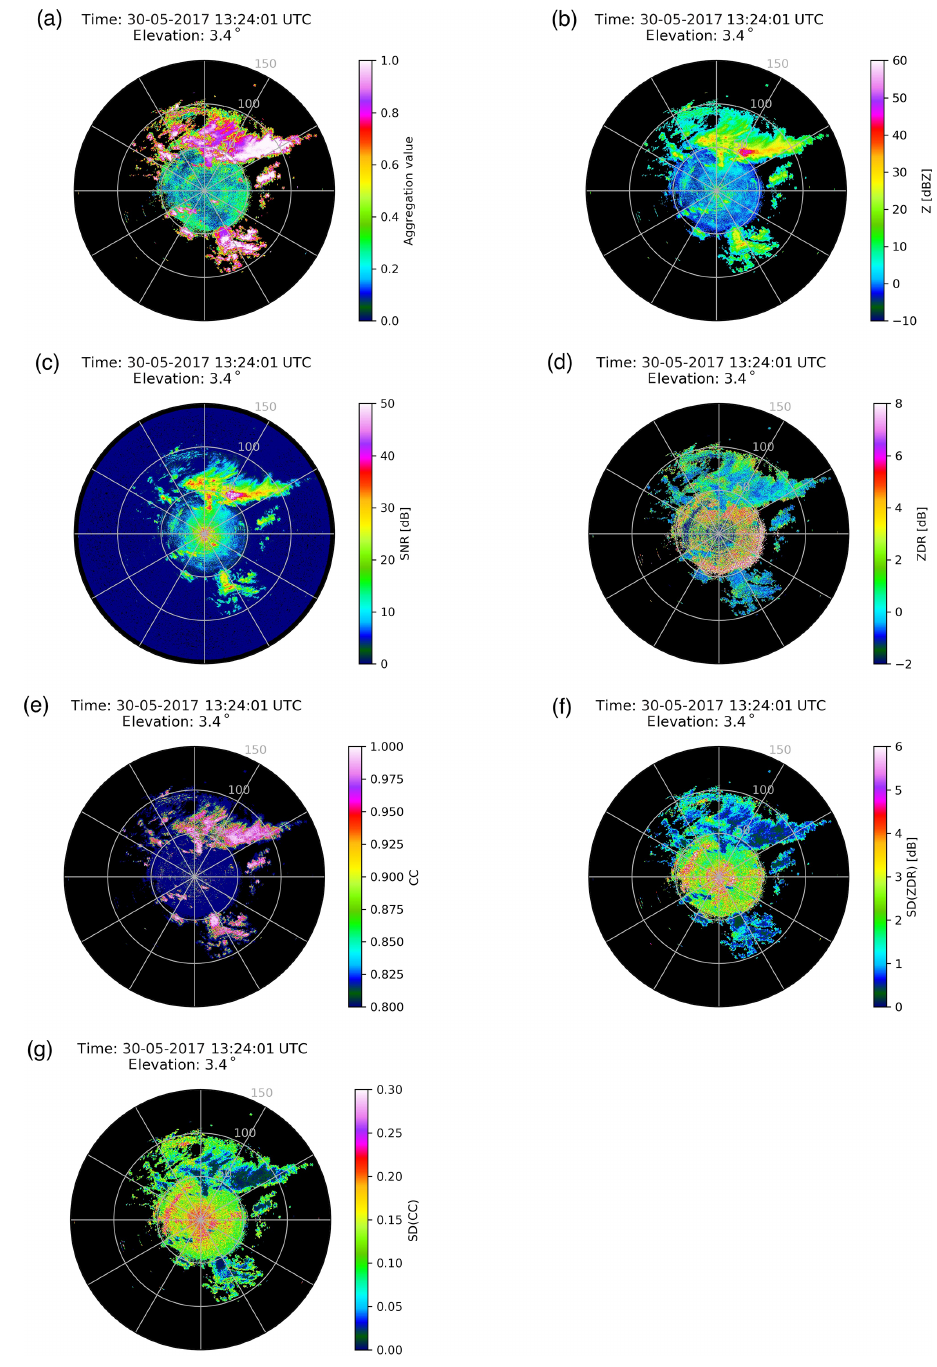
Figure 7. (a) A MET (MetSignal), (b) Z , (c) SNR, (d) ZDR, (e) CC, (f) SD(ZDR), and (g) SD(CC). All from NUIST-CDP at 13:24UTC 30May 2017 from an elevation of 3.4 ◦